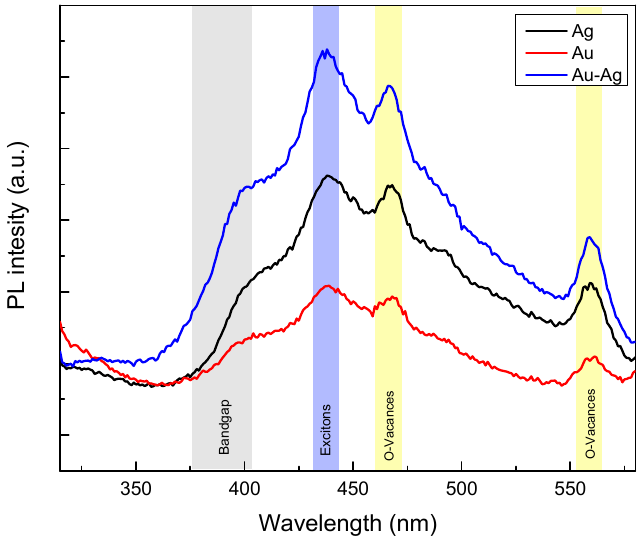
Figure 8. Photoluminescence spectra of TiO 2 films with Ag, Au, and Au-Ag nanoparticles.